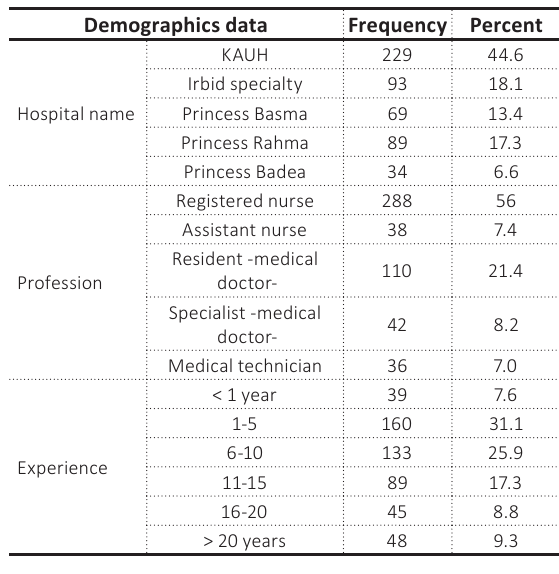
Table 2 (cont.). Participant characteristics